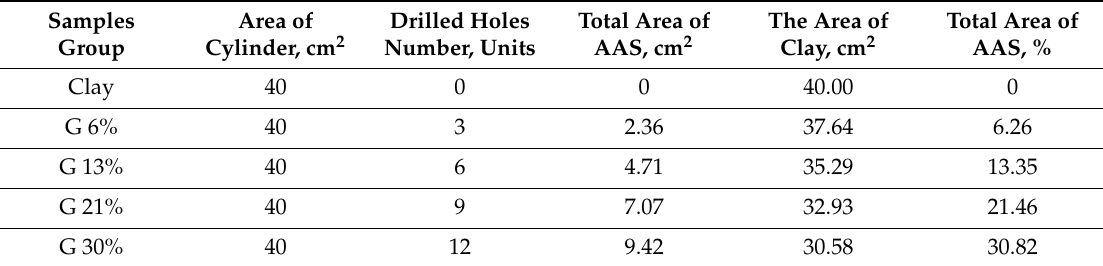
Table 4. Composition of the shear test cylindrical samples.